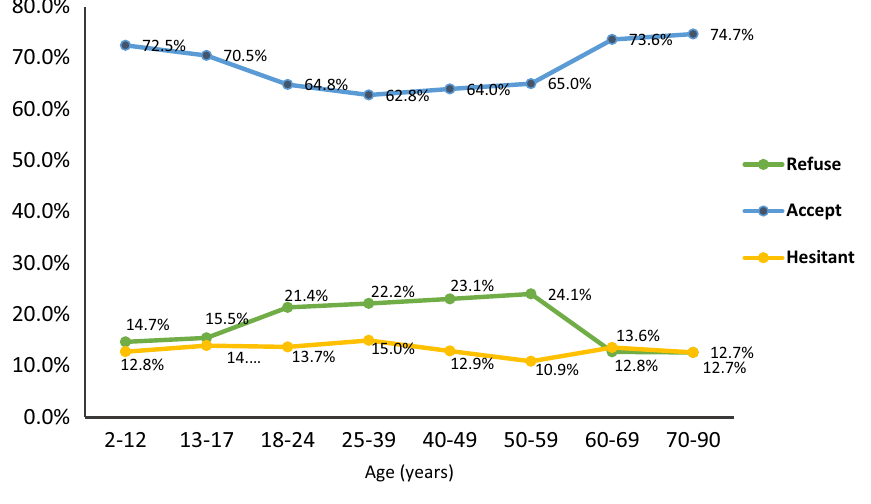
Figure 1. Vaccine acceptance in different age